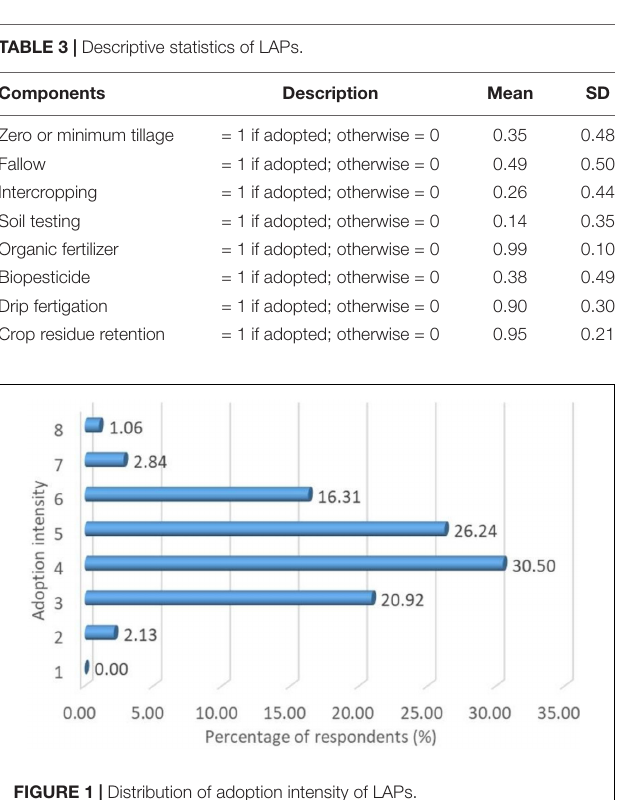
FIGURE 1 | Distribution of adoption intensity of